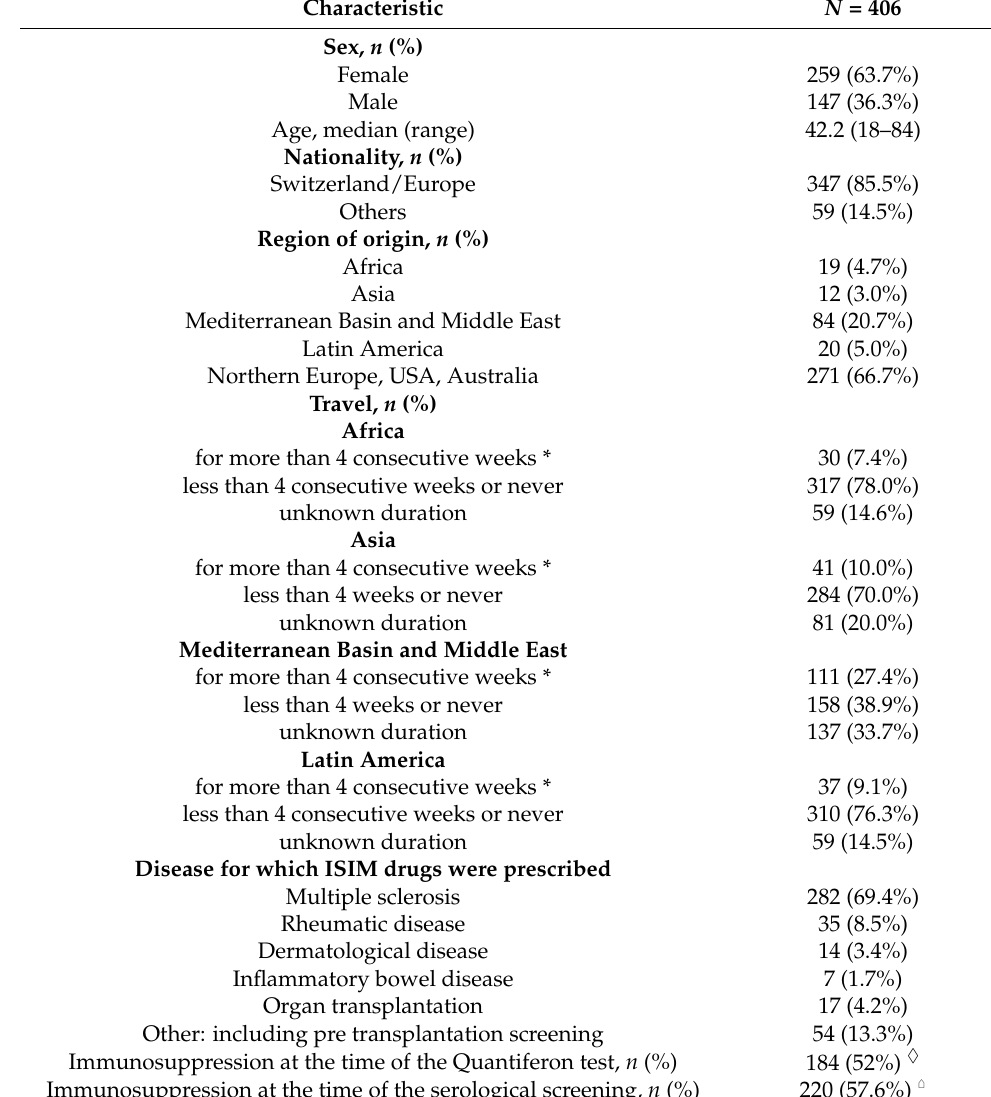
Table 2. Patient baseline characteristics.